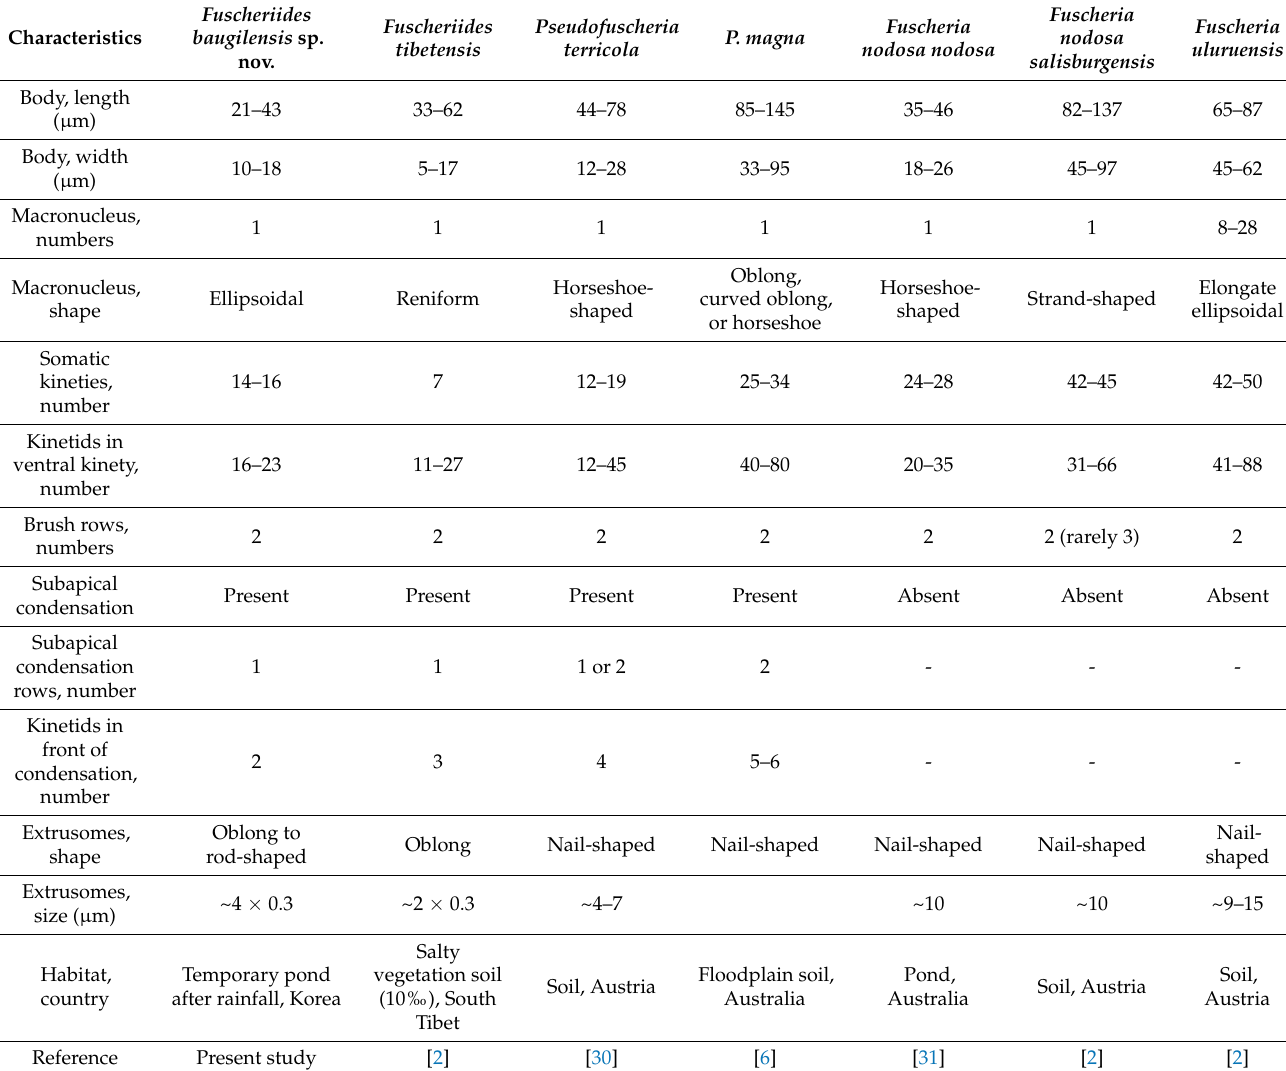
Table 2. Comparison of Fuscheriides baugilensis sp. nov. with closely related